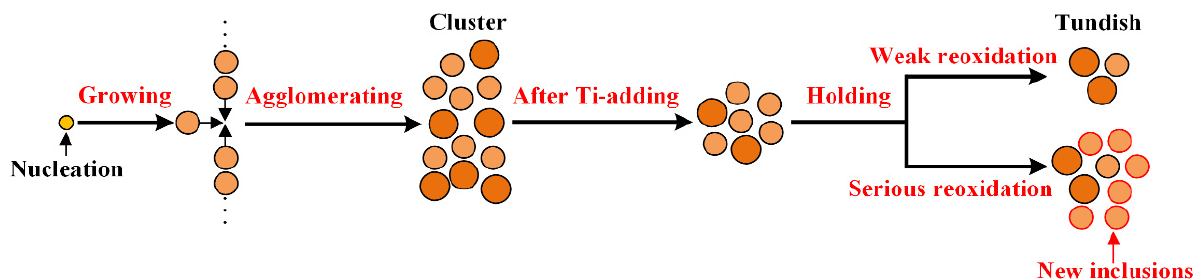
Figure 12. Formation and removal mechanisms of Al 2 O 3 inclusions during RH refining and tundish processes.